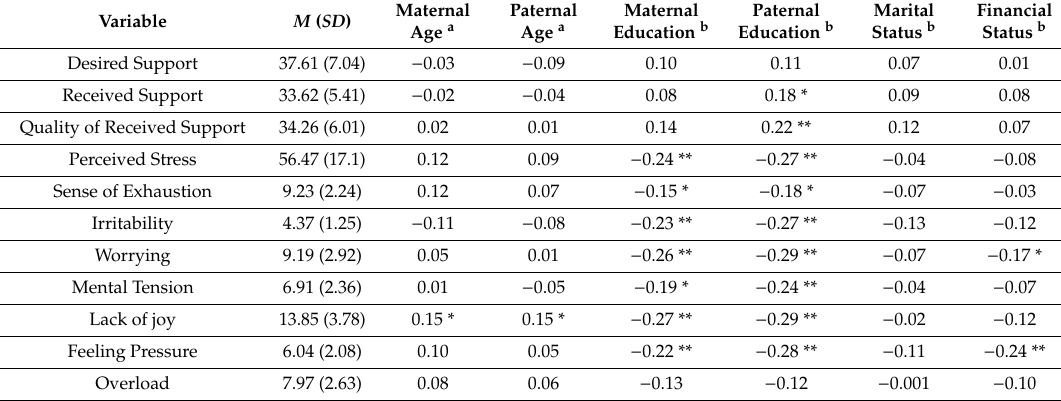
Table 6. Pearson’s linear correlation coe ffi cients and point-two-series correlation coe ffi cients for the relationship of psychological variables with social